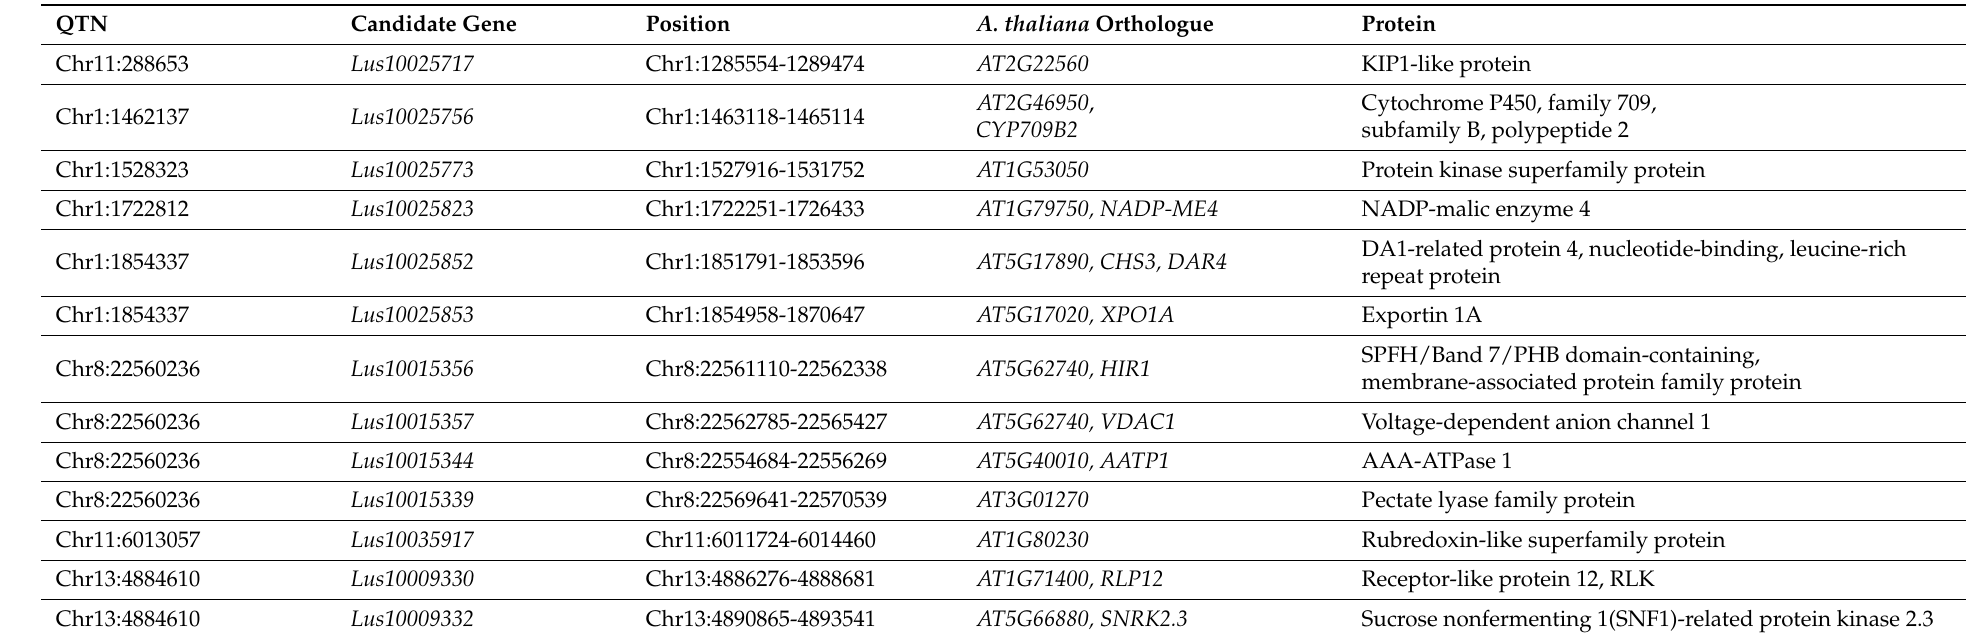
Table 2. Candidate genes located near stable